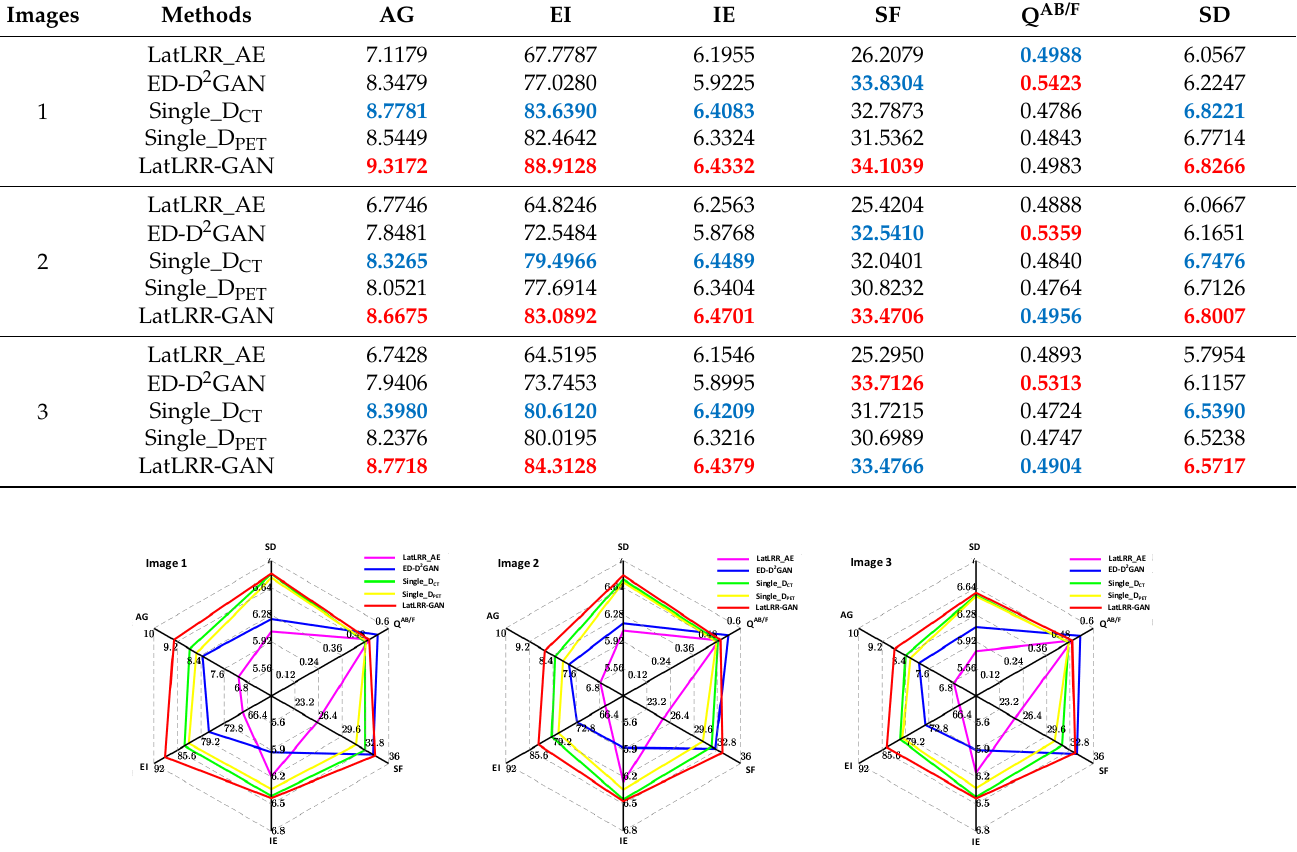
Figure 10. The evaluation metrics’ coefficient radar maps of CT mediastinal window images and PET images about the ablation experiment. Method 1: LatLRR_AE; Method 2: ED-D 2 GAN; Method